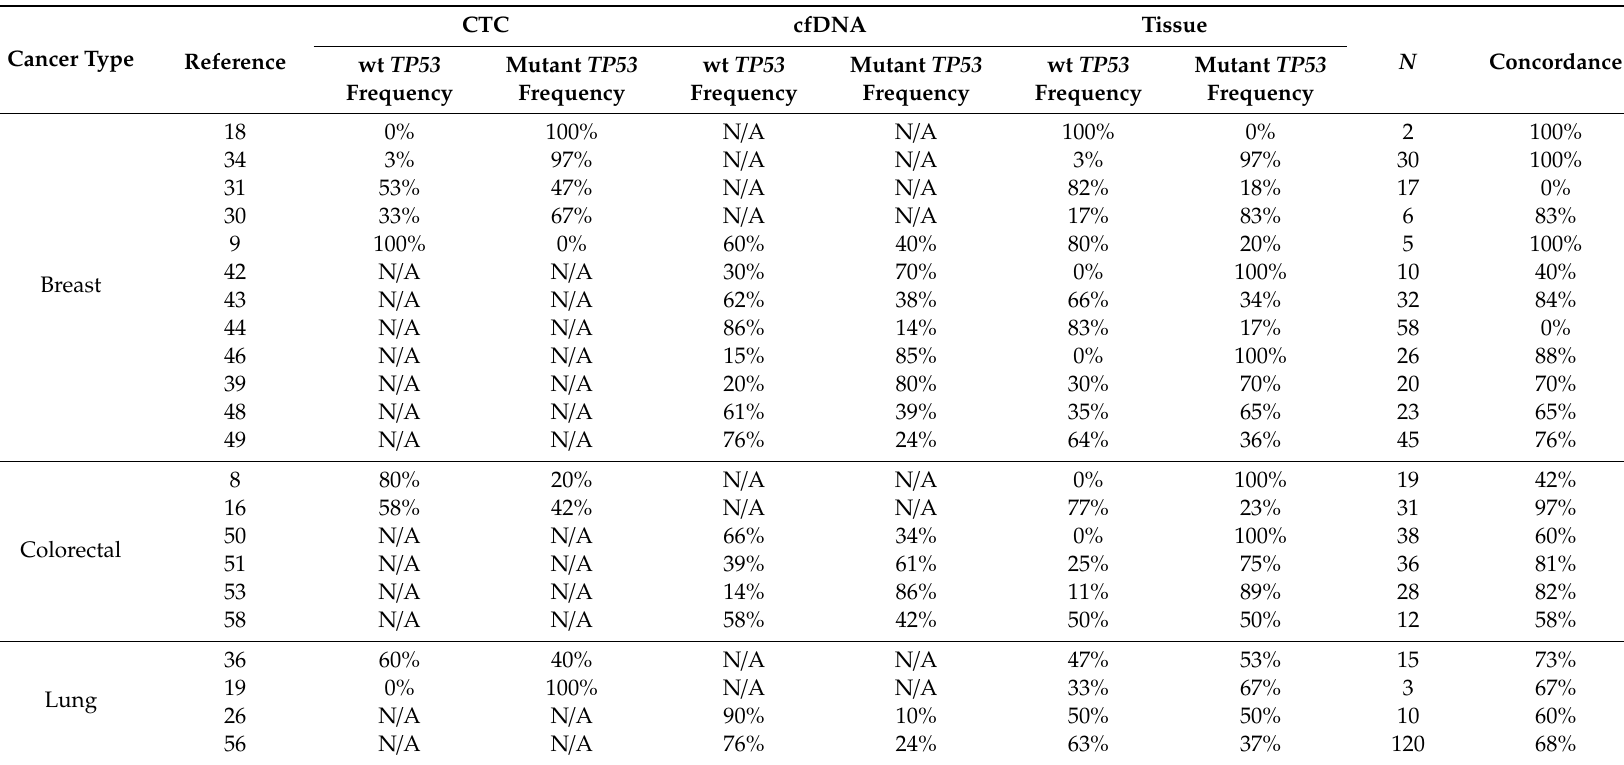
Table 1. Frequencies of mutant and wild type (wt) TP53 reported in di ff erent studies and calculated concordances between circulating tumor cells (CTC) and cell-free DNA (cfDNA) with